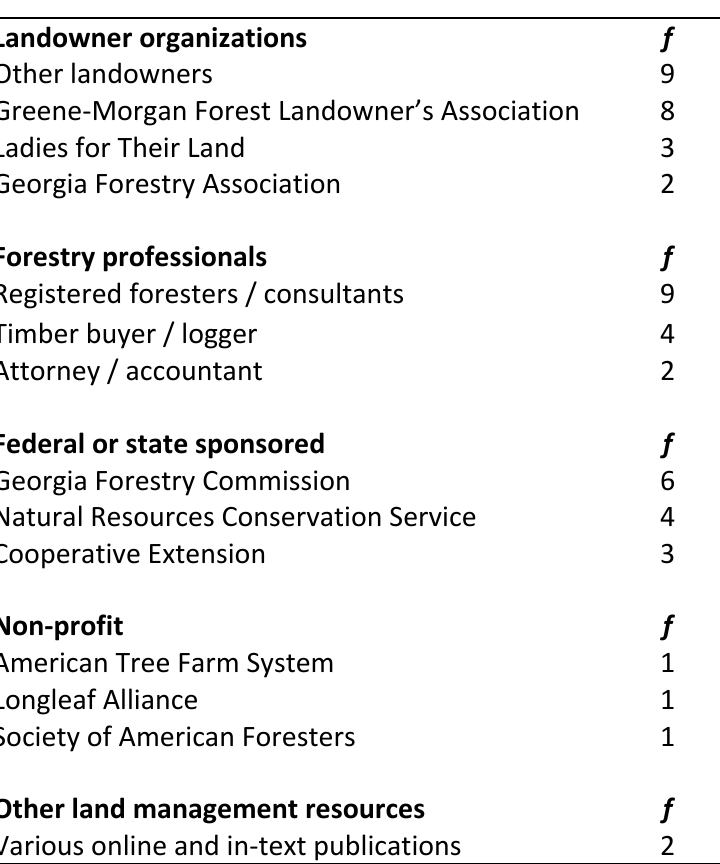
Table 2 Educational Resources Used or Mentioned by Participants via